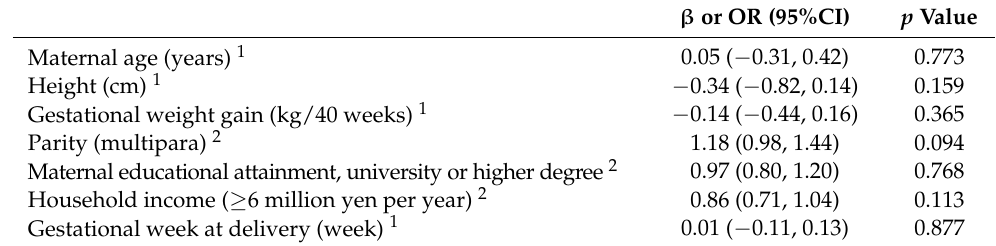
Table 2. Association analyses of pre-pregnancy BMI (continuous variable) with maternal